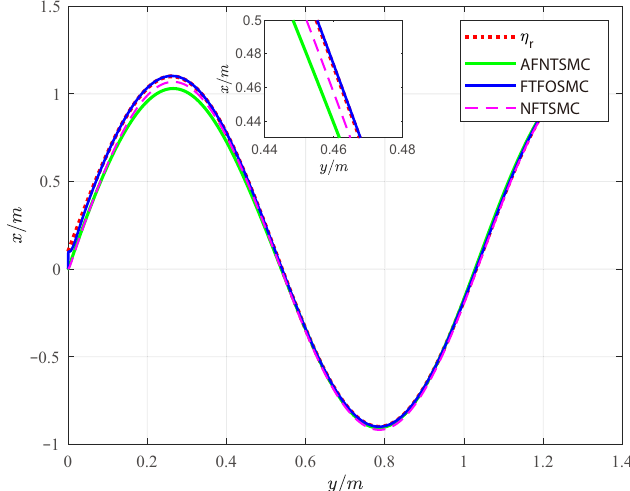
Figure 2. USV trajectory tracking